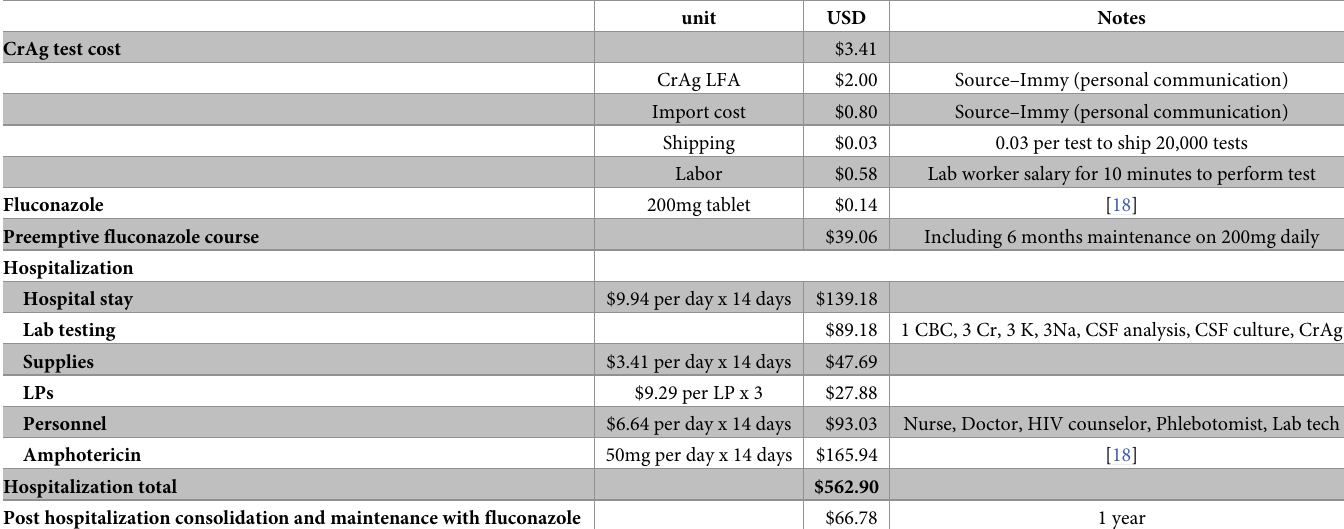
Table 2. Input costs for CrAg screening and treatment.